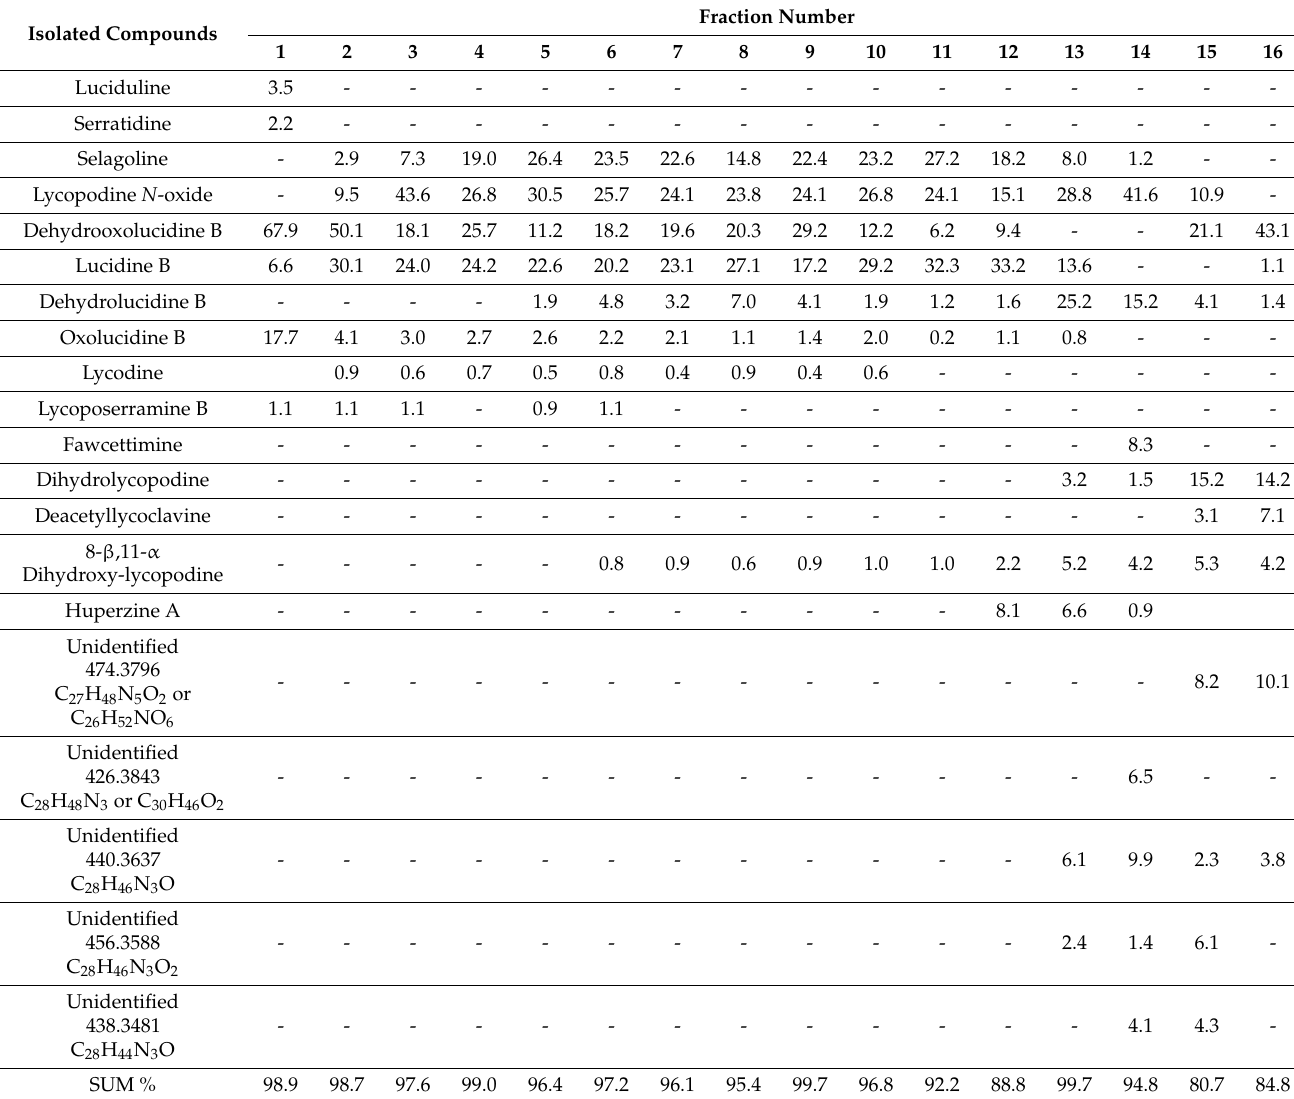
Table 6. Results of alkaloids identified via HPLC/ESI-QTOF-MS present in fractions 1–16 obtained from experiment 2 via VLC using sorbents Al 2 O 3 and silica gel in ratio 3:1 from H. selago extract. Isolated Compounds